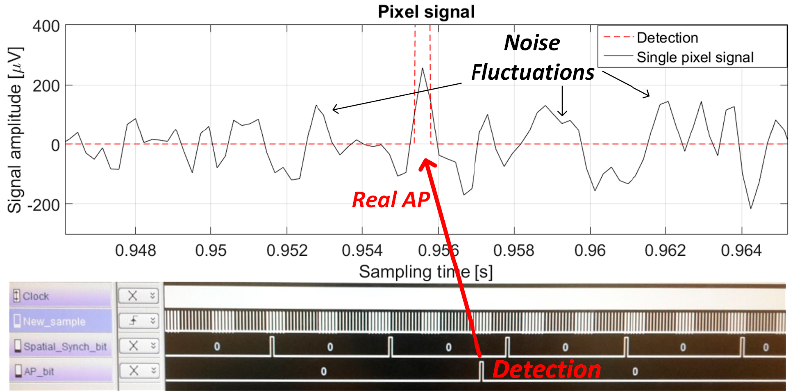
Figure 9. AP detection and single pixel signal with AP.